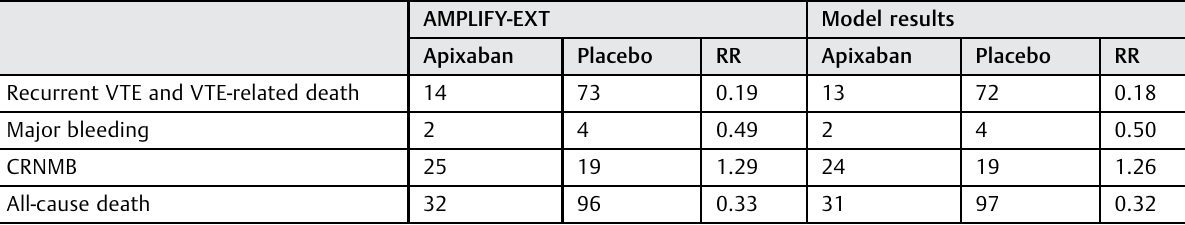
Table 5 Model validation comparing the results of the model to the AMPLIFY-EXT trial outcomes AMPLIFY-EXT Model results Apixaban Placebo